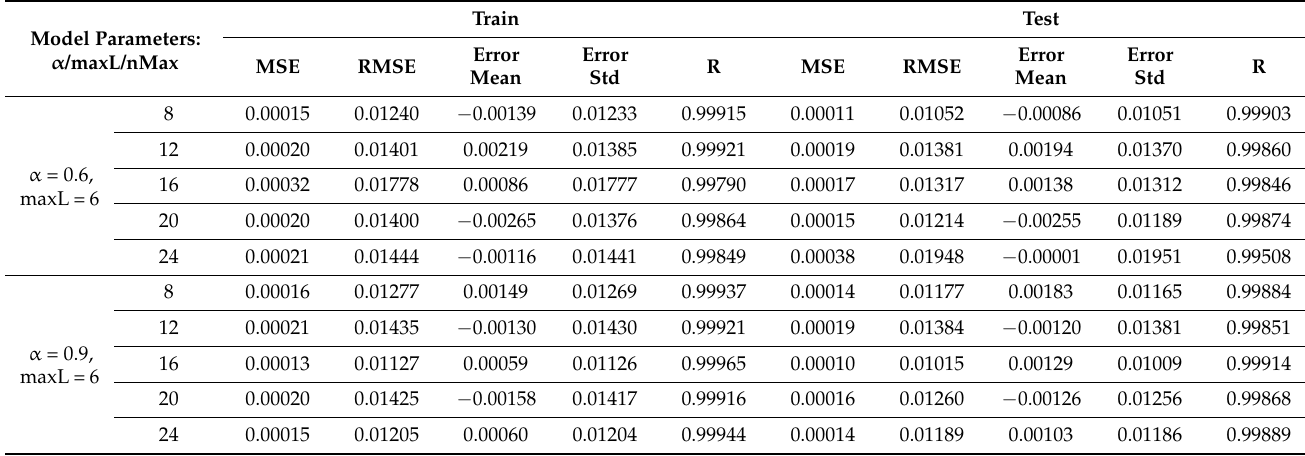
Figure 14a,b show the regression coefficients for the training and testing data, respec- tively.